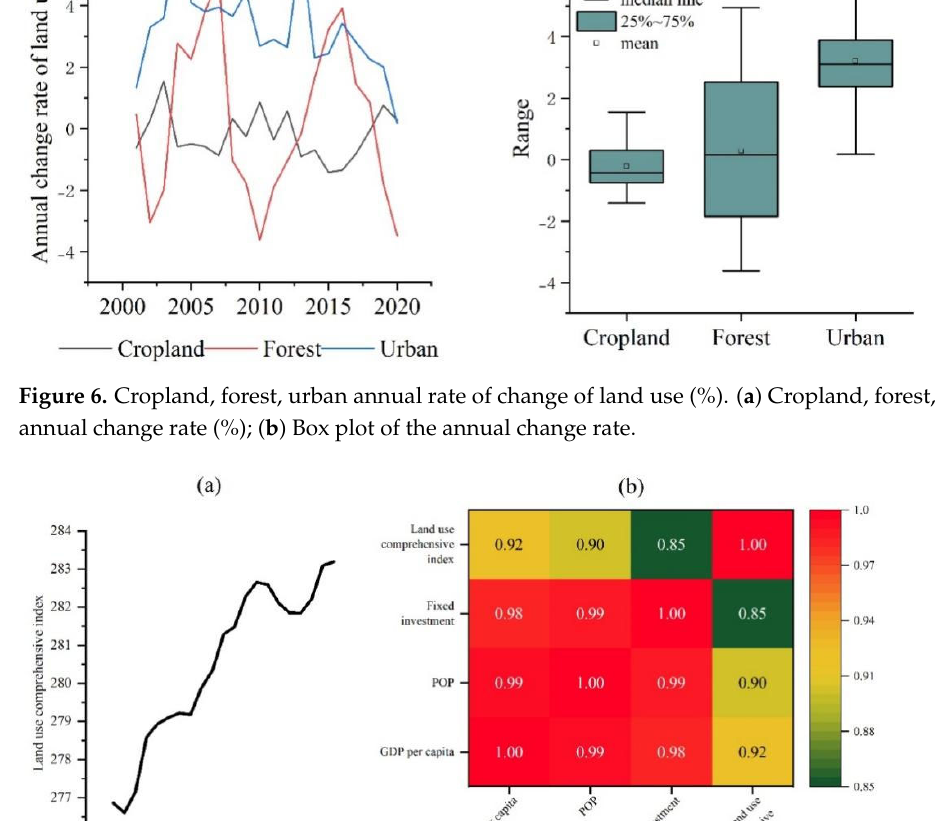
Figure 6. Cropland, forest, urban annual rate of change of land use (%). ( a ) Cropland, forest, urban annual change rate (%); ( b ) Box plot of the annual change rate.